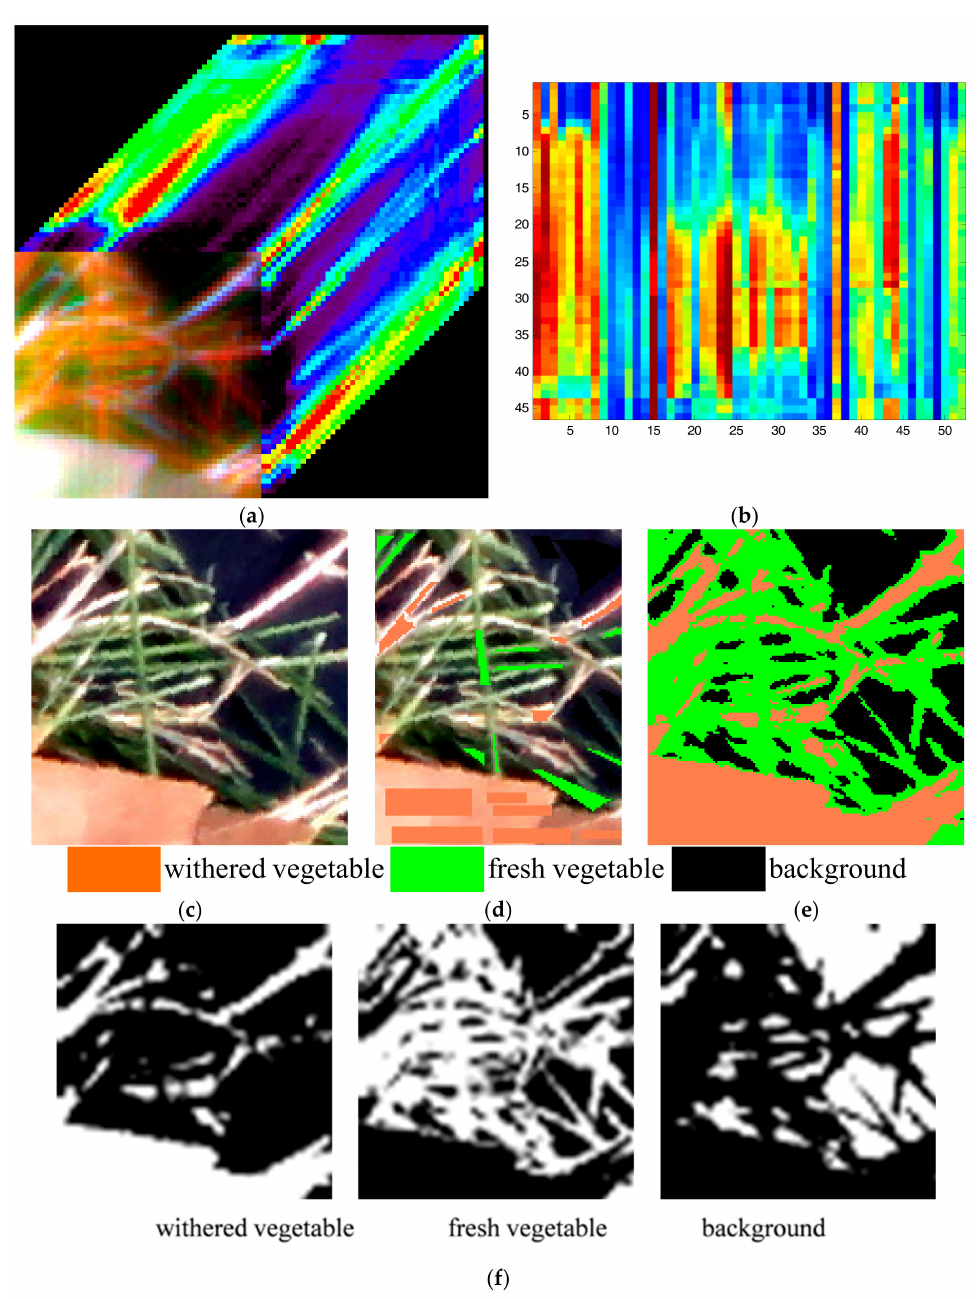
Figure 4. Nuance data. ( a ) R-1. ( b ) Spectral library for R-1. ( c ) High resolution (HR) image. ( d ) The regions of interest (ROIs). ( e ) Support vector machine (SVM) classification map. ( f ) Reference